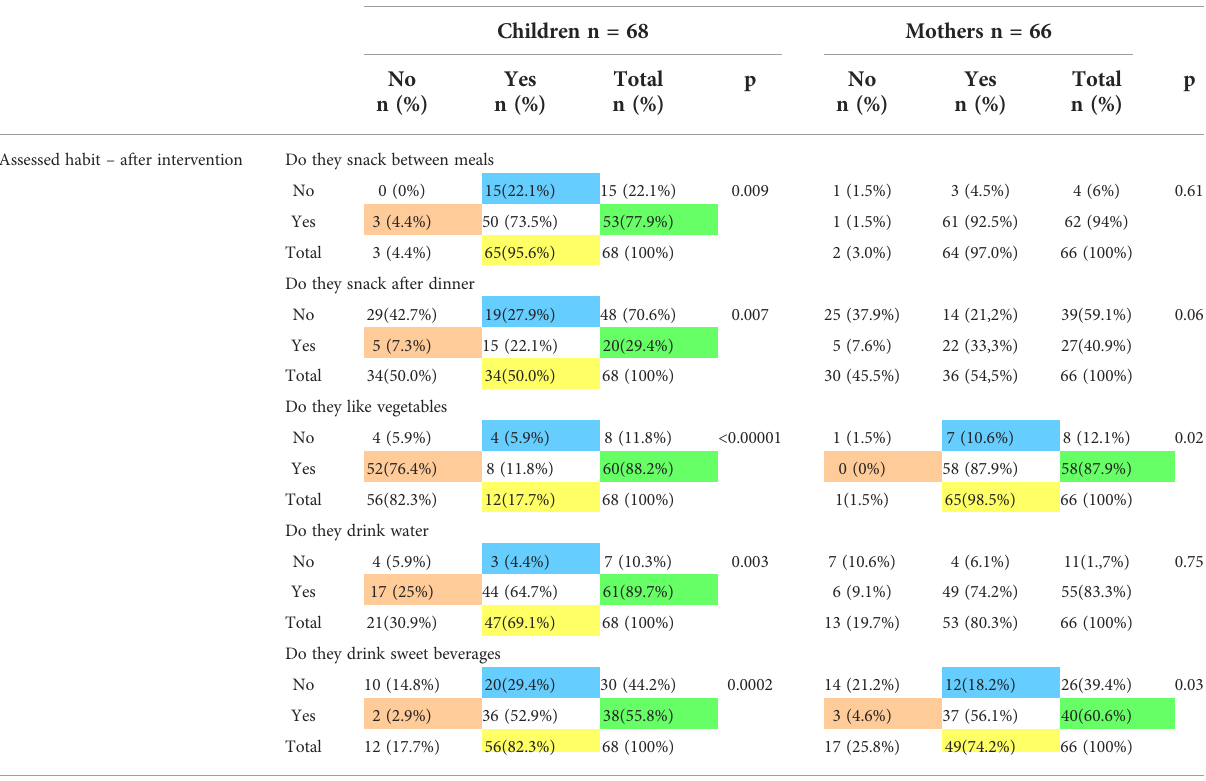
TABLE 4 Effect of one-year dietary intervention on changes in dietary habits in studied children and their mothers. Assesed habit Assessed habit – before